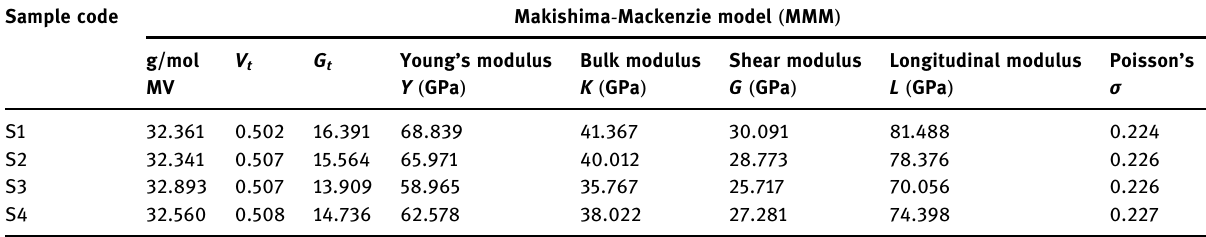
Table 2: Mechanical properties of the investigated glasses Sample